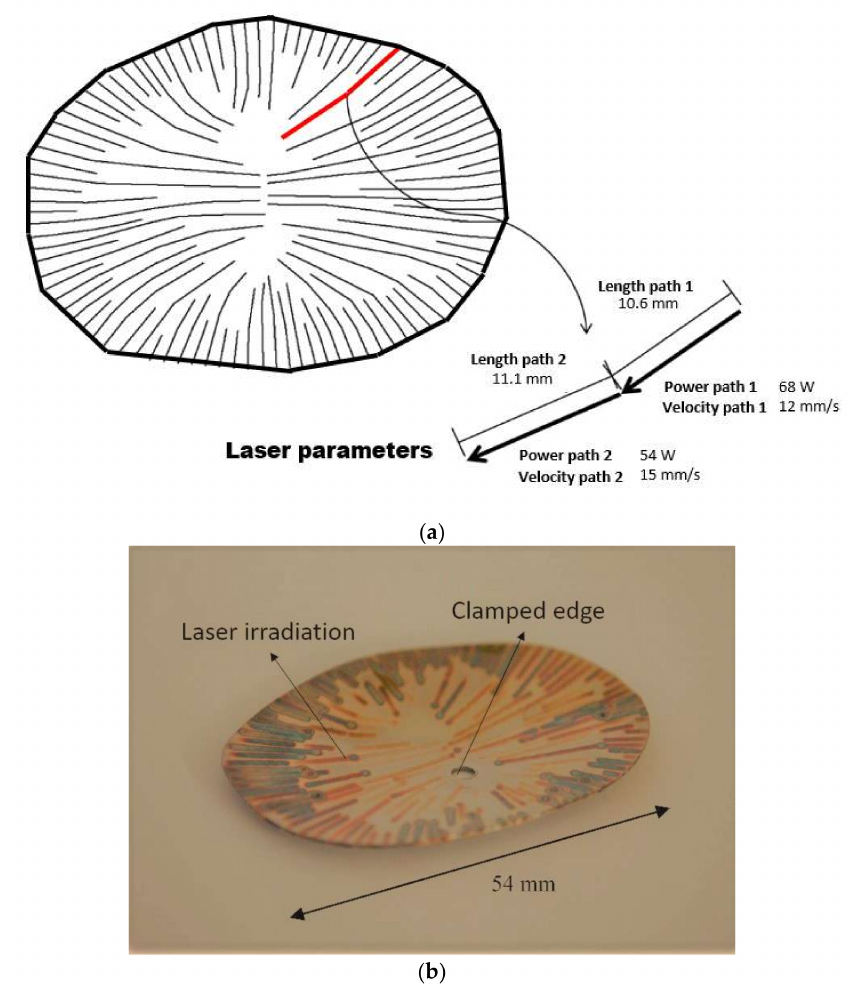
Figure 5. Single piecewise linear scanning paths: ( a ) laser paths and heating conditions for a certain path and ( b ) final bent